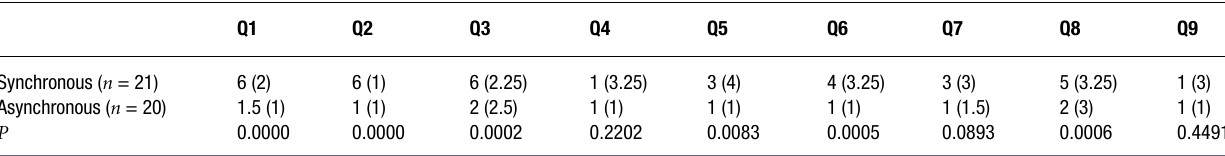
Table 1 | Medians and interquartile ranges of the questionnaire scores.